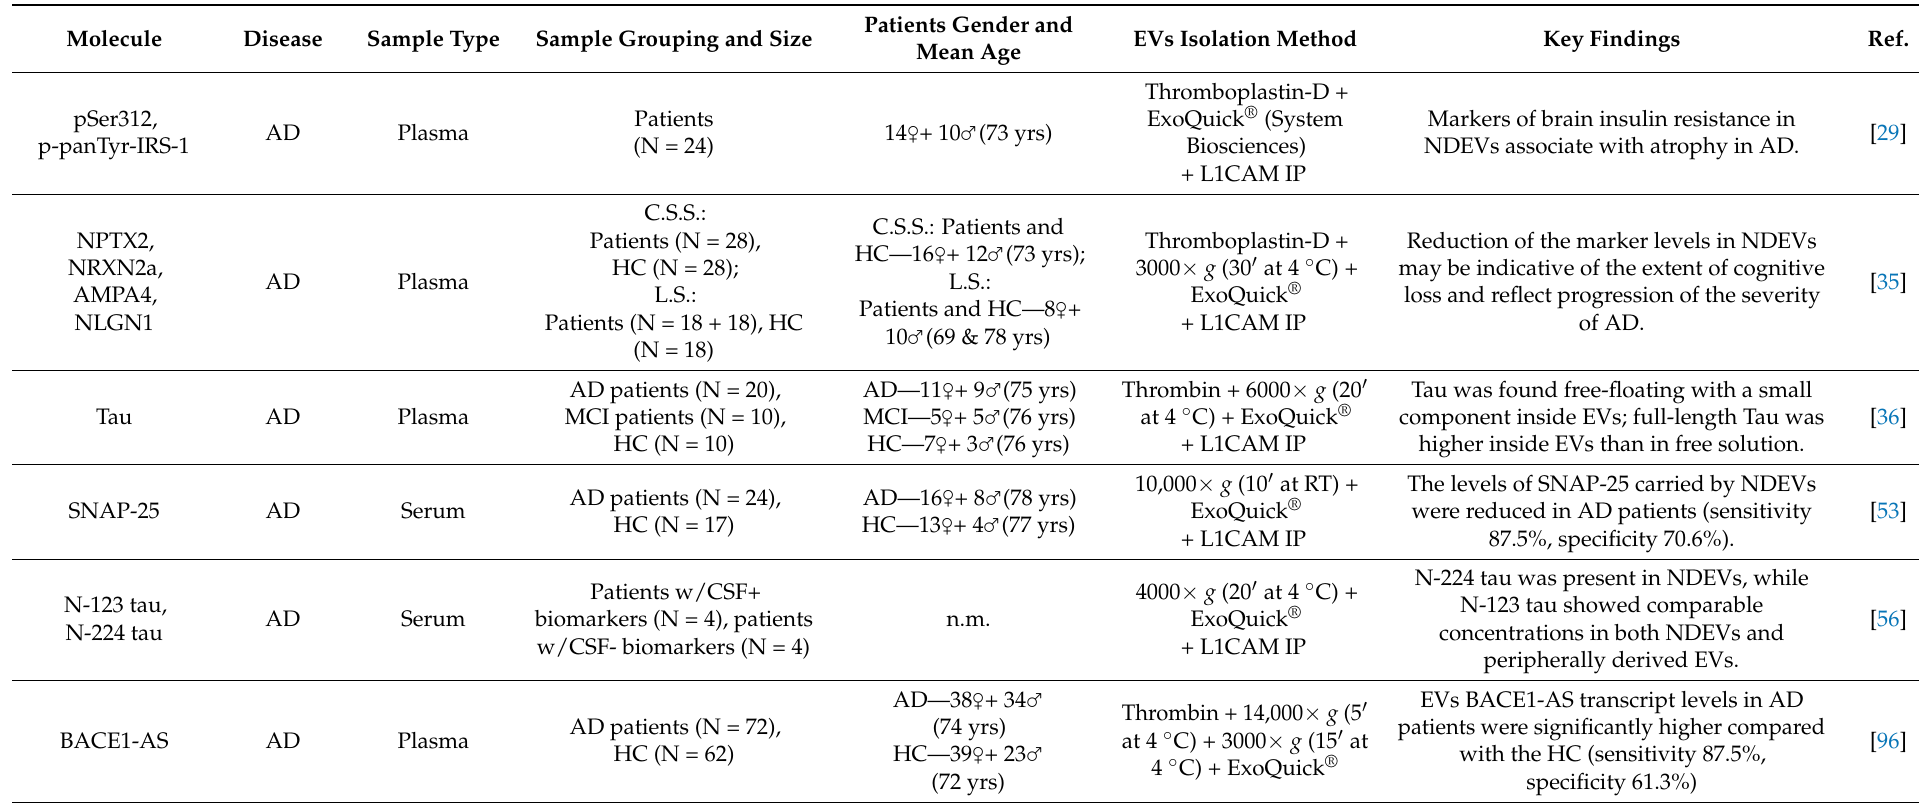
Table 1. Extracellular vesicles protein and protein-coding genes transcripts as biomarkers associated with central nervous system pathological conditions.